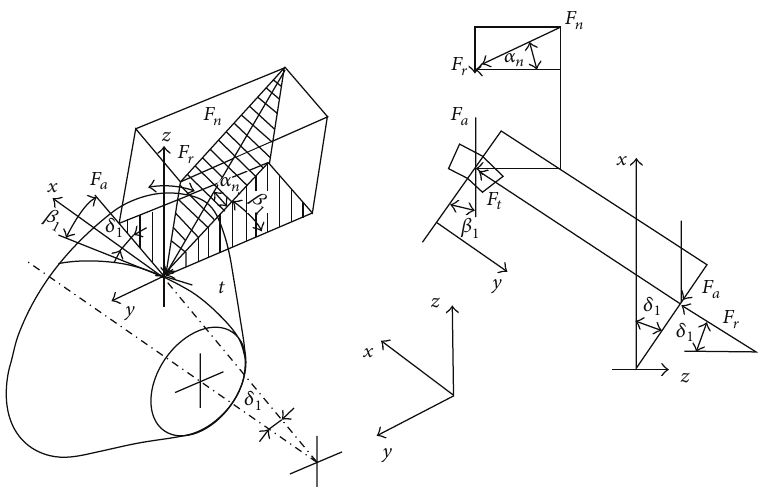
Figure 2: Force analysis of the